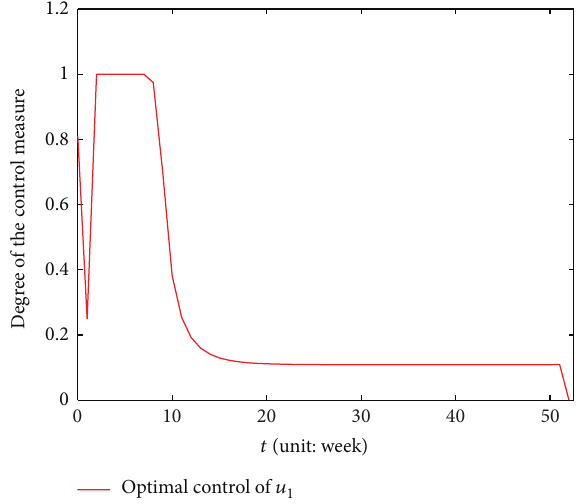
Figure 15: Figures of the optimal control 𝑢 1 when we choose the weight in objective function are 𝑐 1 = 10 4 , 𝑐 2 = 10 2